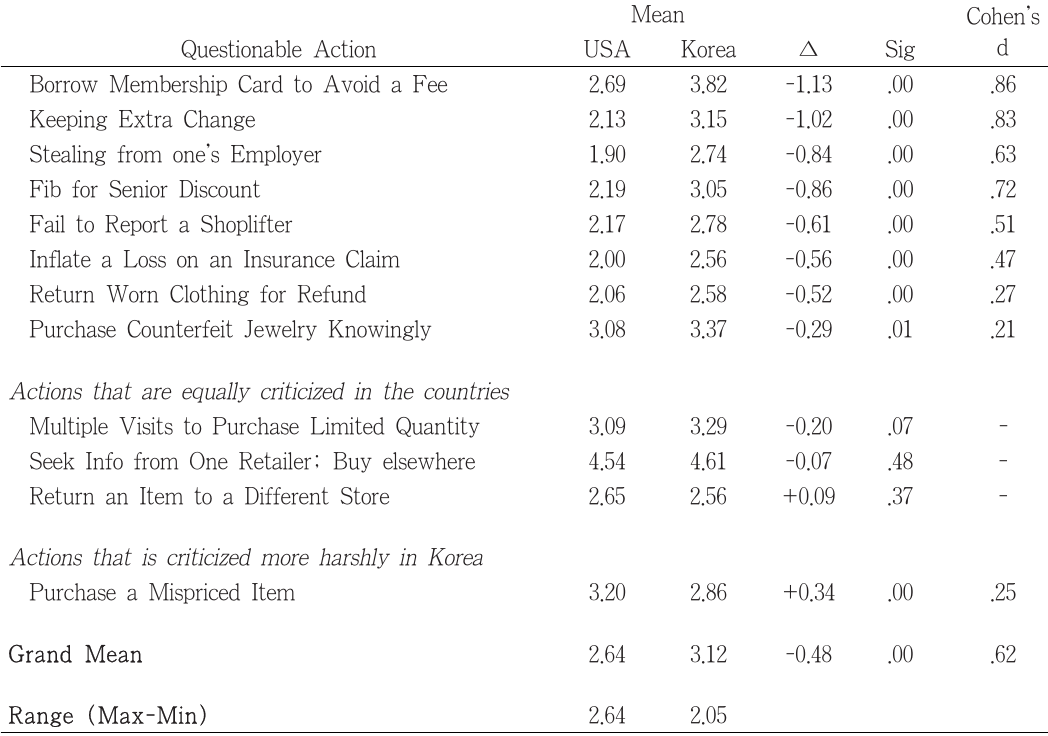
<Table 3> Cross-Cultural Differences of Acceptability – USA versus